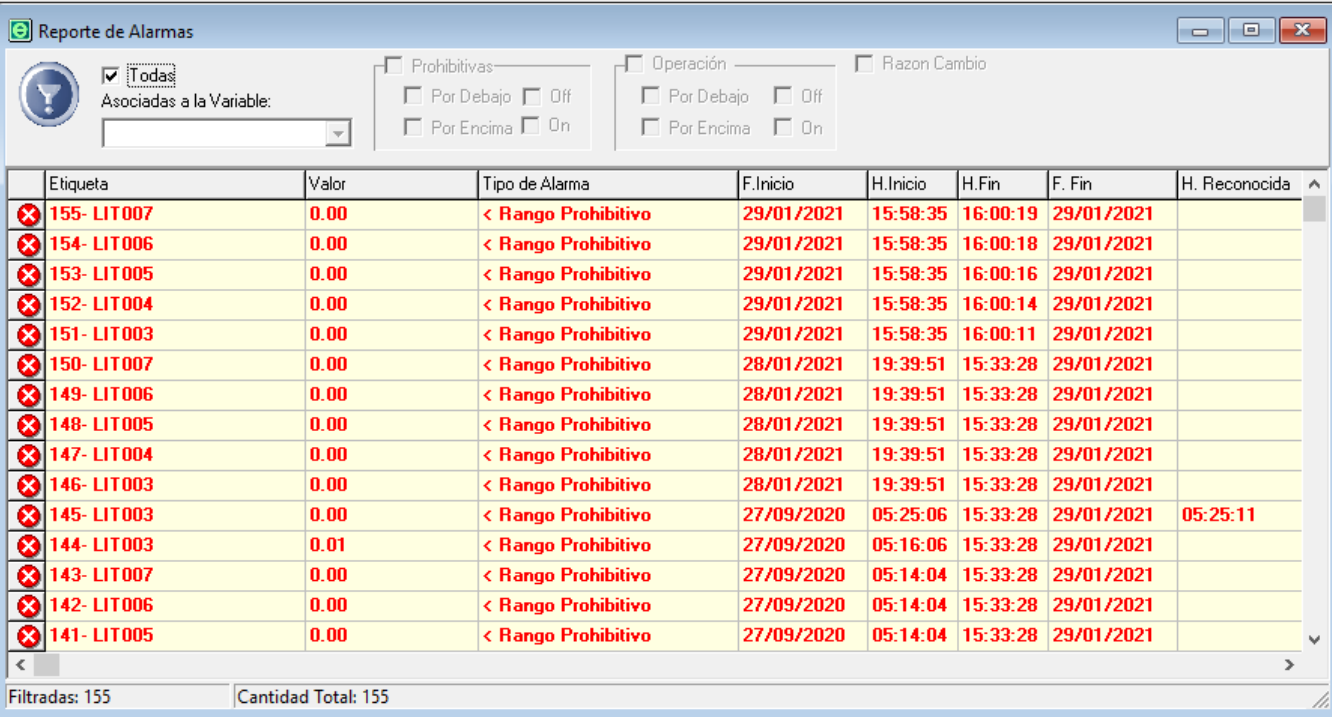
Figure 10: Alarms